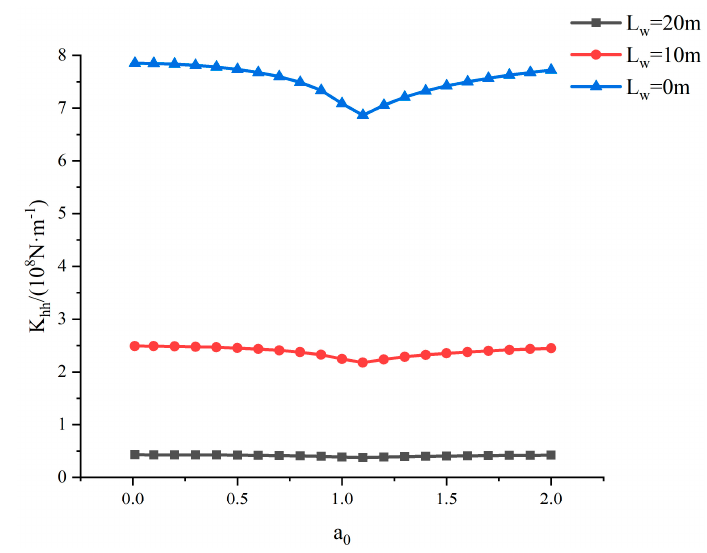
Figure 15. The influence of the pile length in seawater on the foundation impedance.